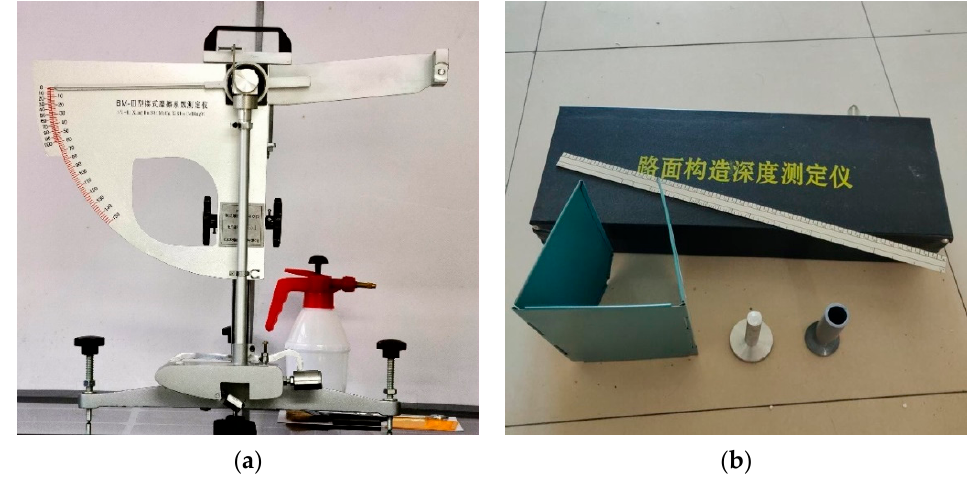
Figure 7. Testing equipment: ( a ) pendulum friction device; ( b ) avement structure depth tester.